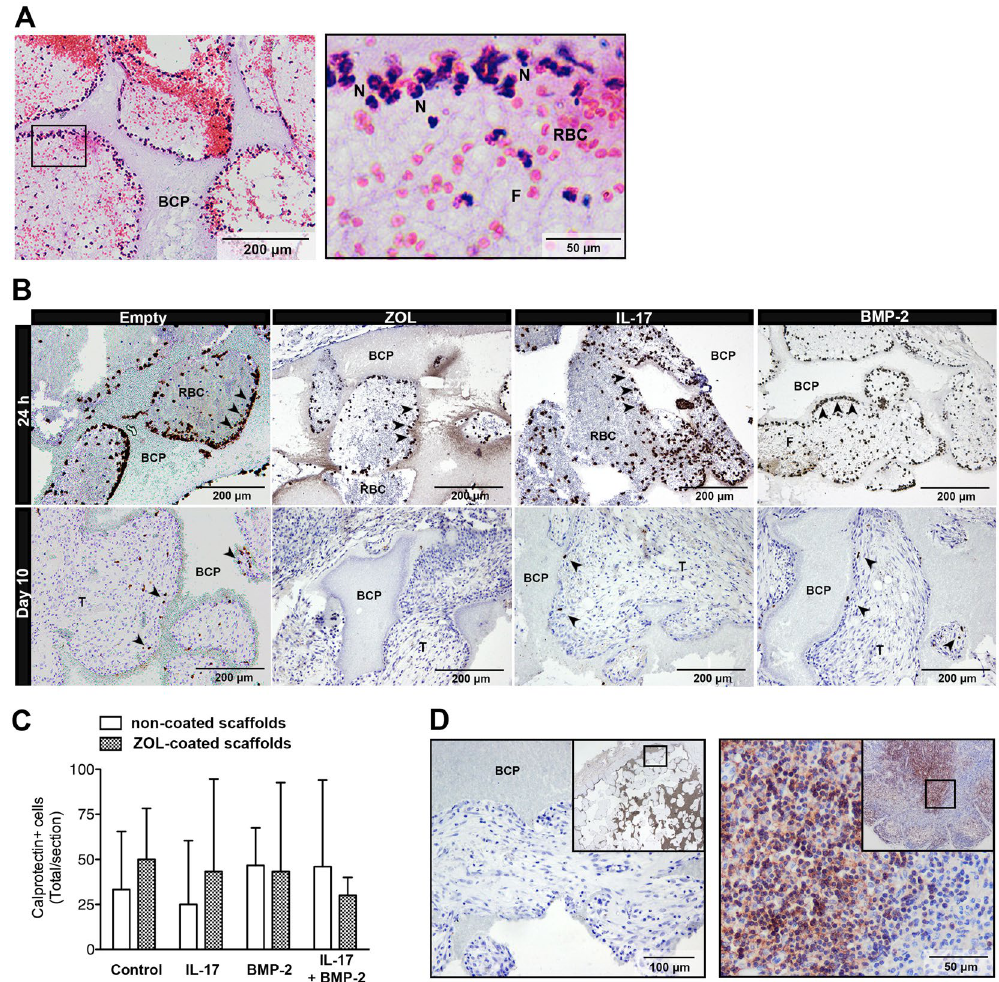
Figure 3. Inflammatory response after 24 hours and 10 days. ( A ) H&E staining was performed on an empty scaffold retrieved after 24 days. This sample is representative for all 24 h samples. ( B ) Calprotectin staining (in brown, arrowheads) was performed to demonstrate activated phagocytes in the constructs after 24 h or 10 days. ( C ) Calprotectin-positive cell count at day 10, represented as the mean ± SD (n = 3). ( D ) CD3 staining for T lymphocytes was performed on an empty scaffold retrieved after 10 days (left panel). This sample is representative for all day 10 samples. A rabbit lymph node was used as a positive control (right panel). The top right insets provide an overview. BCP, biphasic calcium phosphate; F, fibrin network; N, neutrophils; RBC, red blood cells; T, connective